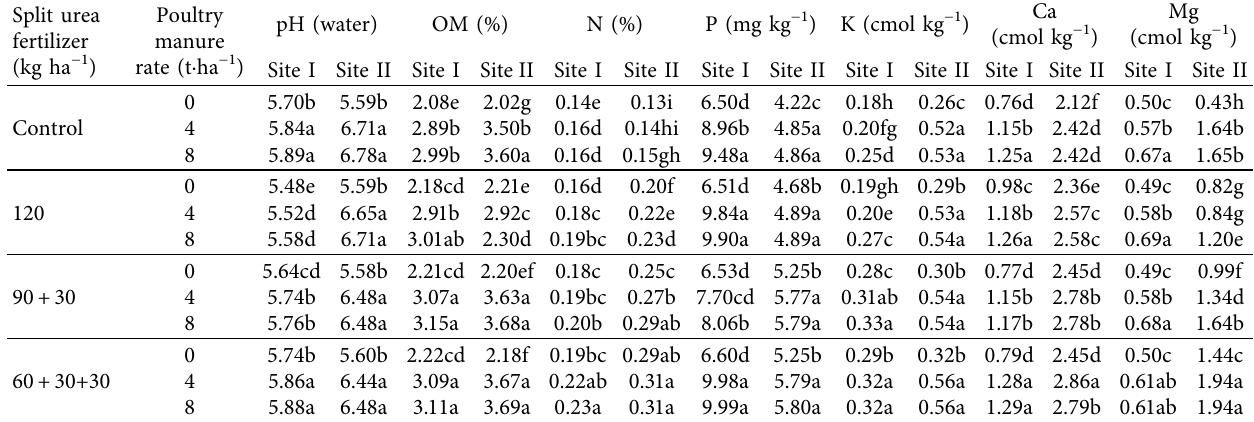
Table 2: Effects of poultry manure and split urea fertilizer on soil chemical properties.